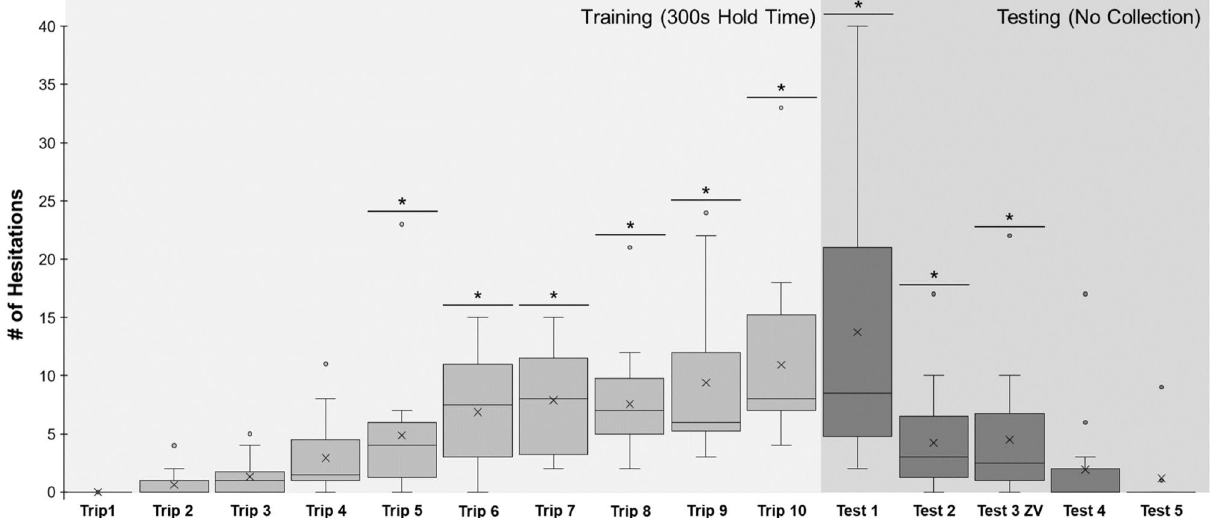
Figure 3. Forager hesitations during training and testing in the Aversive Learning tests. Foragers were collected at Site 2 during training (Trips 1–10, light grey), for 300 s and were then allowed to return to the foraging route. During testing (Test 1–5, dark grey), foragers were allowed to travel through Site 2 and return to the nest. Box plots show the median hesitations, consisting of scans and stops, across training and testing (middle line), mean hesitations (×) and 25th and 75th percentile (box) while the whiskers extend to min and max values (excluding outliers). Outliers were defined as values 150% of the IQR beyond 25th and 75th percentile and represented as individual points. *Denotes training or test trips where forager hesitations are significantly above the Trip 1 baseline (p <